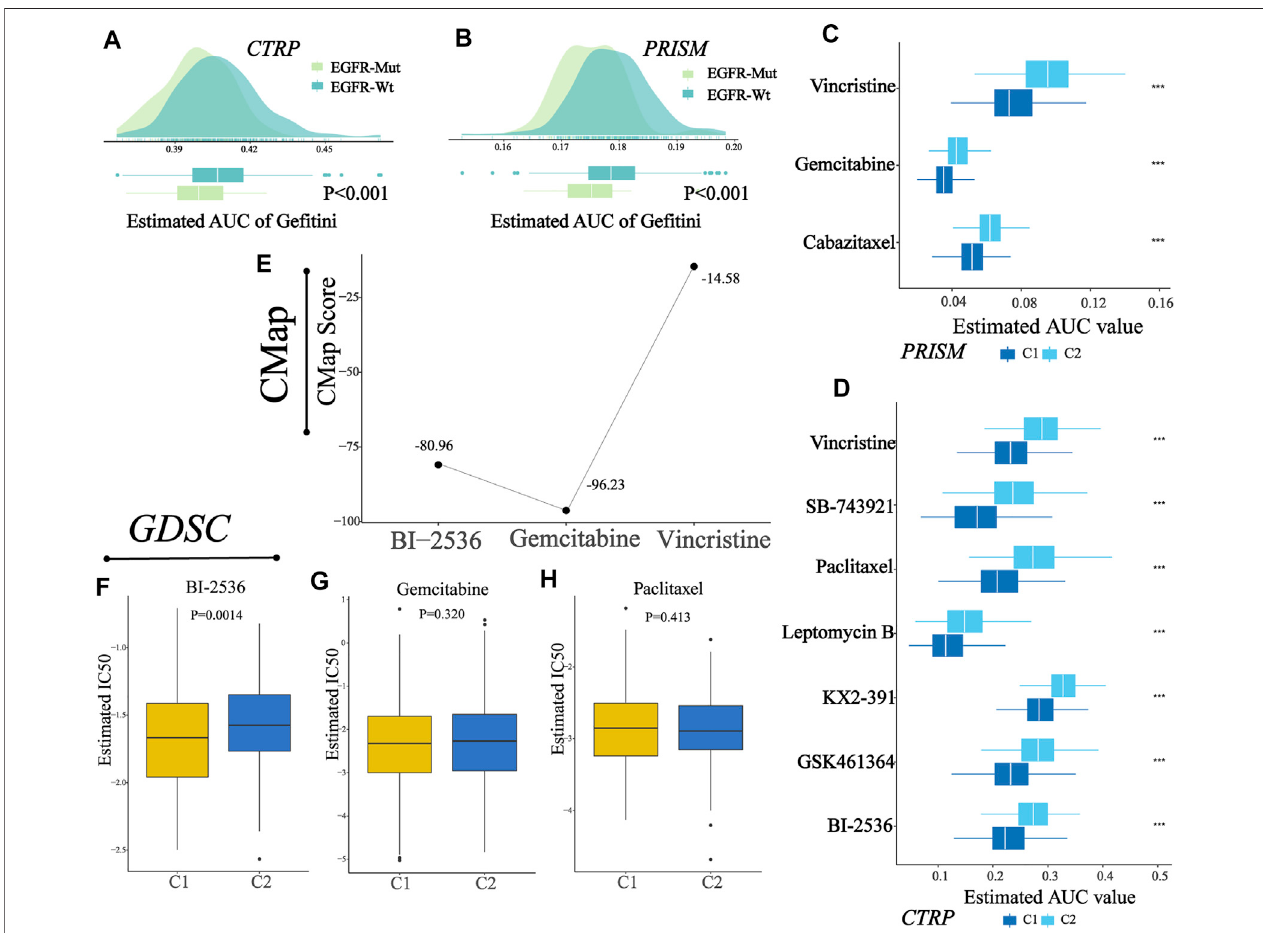
FIGURE9| Identi fi cation ofapotentialagent withhigher sensitivity for patients in C1. (A – B) Comparison ofpredicted Ge fi tinisensitivitybetweenEGFR altered and unaltered groups. (C) Results of drug sensitivity analysis of three PRISM-derived compounds (vincristine, gemcitabine, and cabazitaxel). (D) Results of drug sensitivity analysisofsevenCTRP-derivedcompounds(vincristine,SB-743921,paclitaxel,leptomycinB,KX2-391,GSK461364,andBI-2536). (E) CMapscoreofthreecandidate compounds (BI-2536, gemcitabine, and vincristine). (F – H) Comparison of estimated IC 50 for BI-2536, gemcitabine, and paclitaxel in C1 and C2.